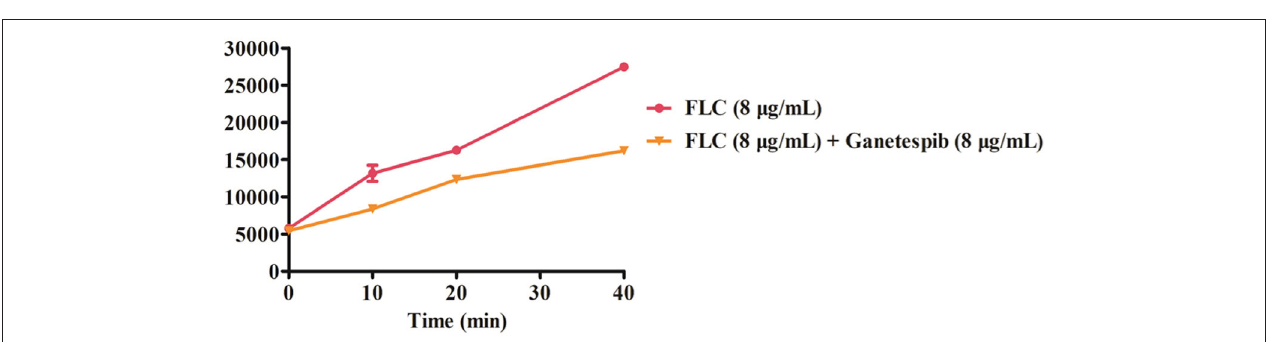
FIGURE 5 | Extracellular fluorescence intensity of Rh6G treated with